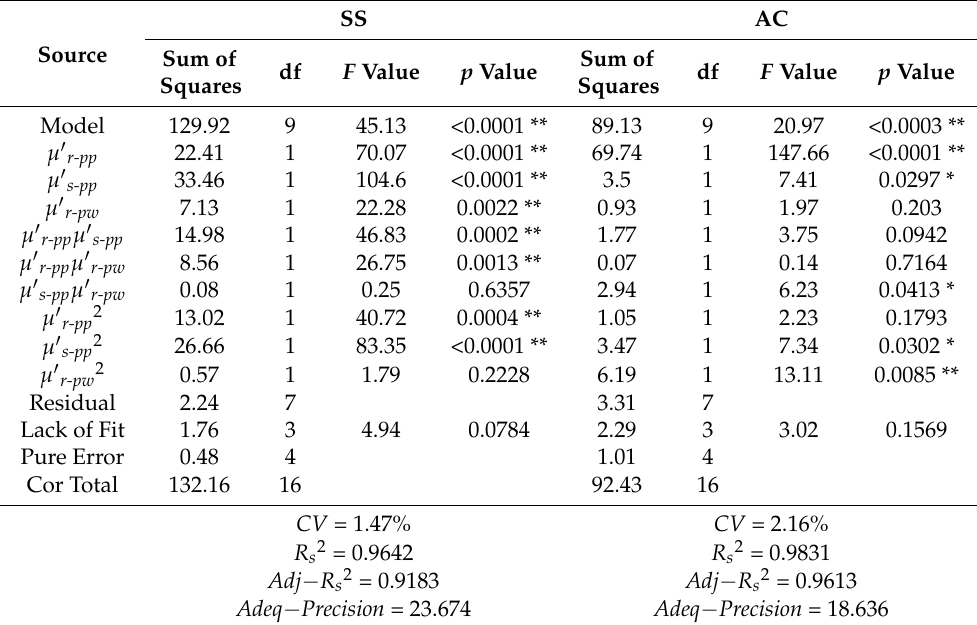
Table 6. ANOVA results of BBD